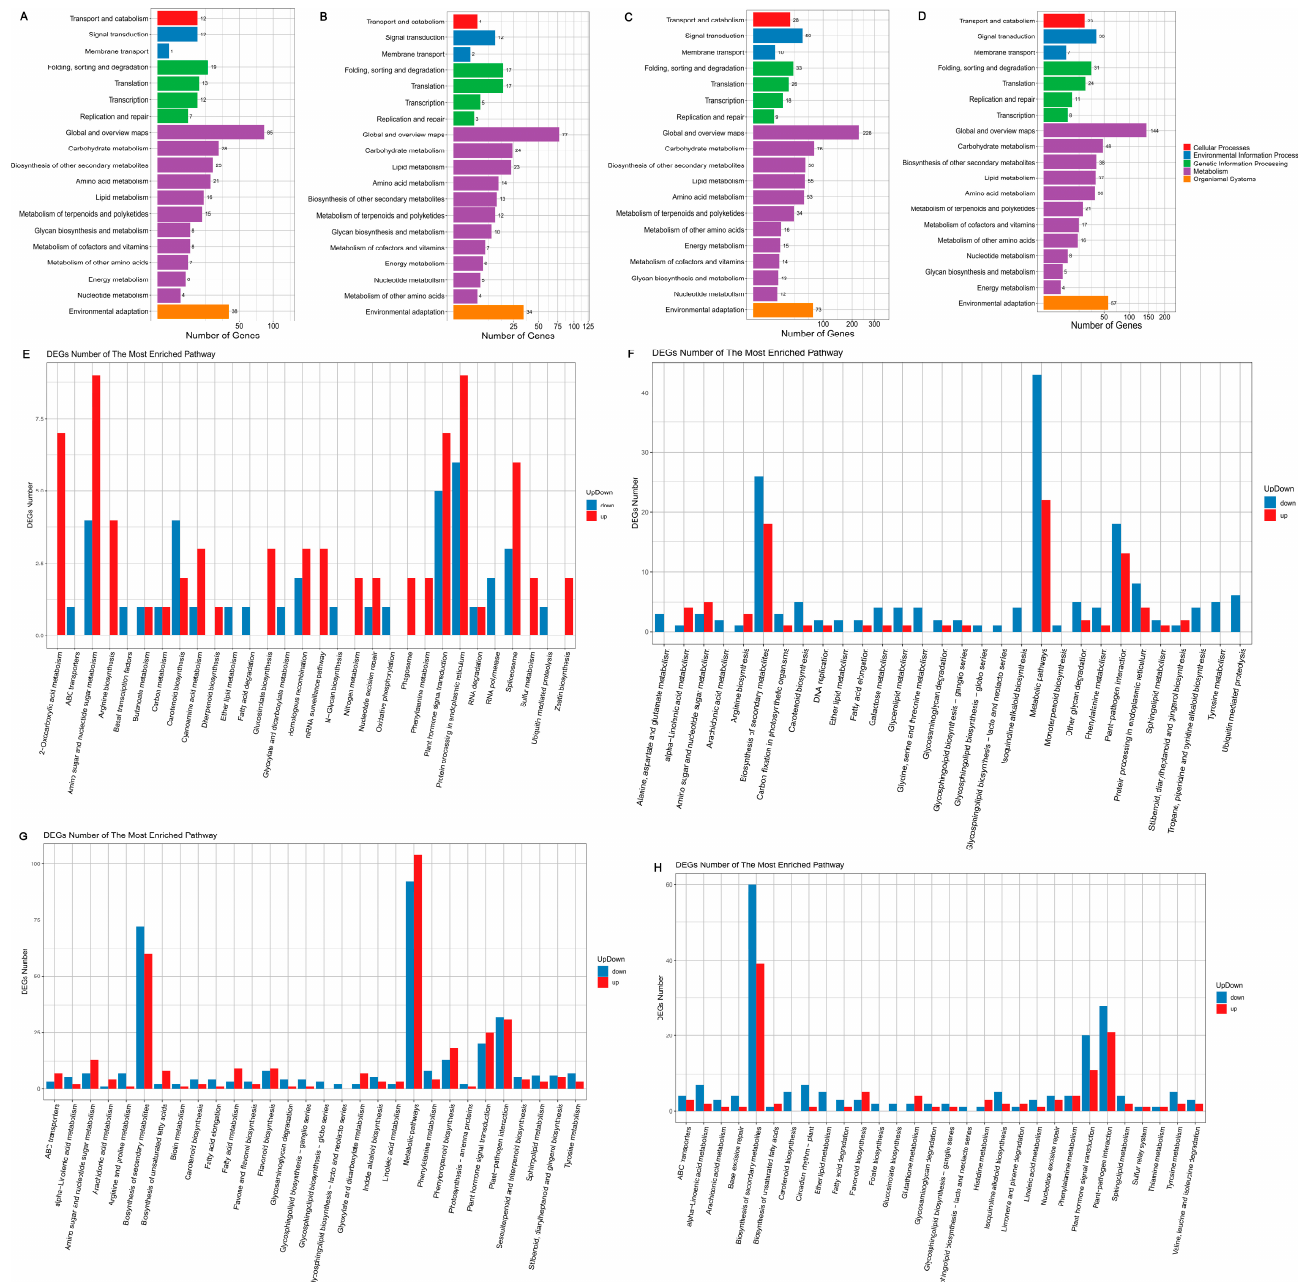
Figure 5. KEGG pathway classification of DEGs among different eggplant varieties. KEGG plots of groups 30-14 vs. 22-14 ( A ), 30-22 vs. 22-22 ( B ), QPCQ-14 vs. 22-14 ( C ), and QPCQ-22 vs. 22-22 ( D ). Top 30 pathways and up-/downregulated DEGs in these pathways in groups 30-14 vs. 22-14 (E), 30-22 vs. 22-22 ( F ), QPCQ-14 vs. 22-14 ( G ), and QPCQ-22 vs. 22-22 ( H ).